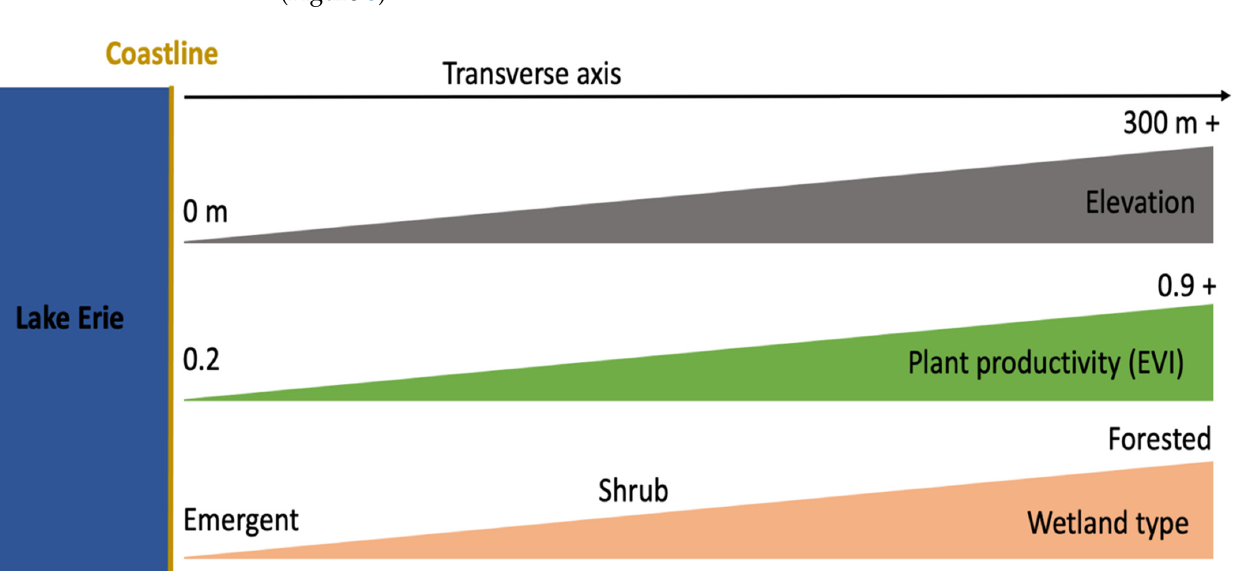
Figure 8. The coastal structure along the transverse